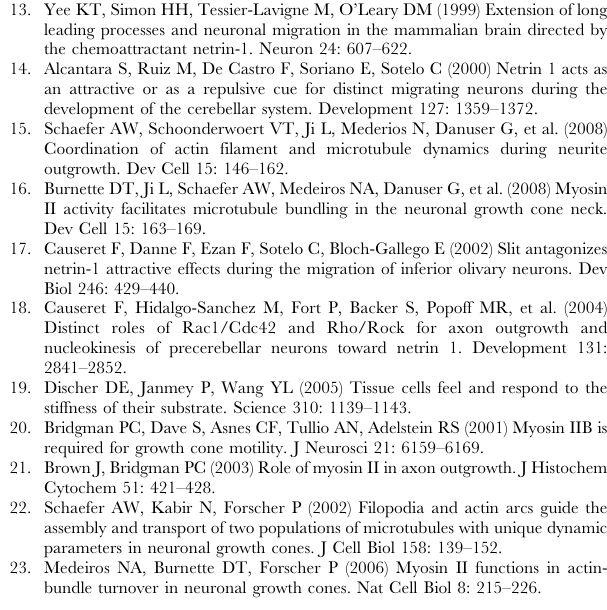
Figure S3 Comparison of neurites branching in wt and TTL 2 / 2 neurons growing in a collagen matrix. The aspect of GFP- electroporated growing neurites from wt (A, B) and TTL 2 / 2 (C, D) E12 explants toward Netrin-1 were observed after immuno- labeling with anti-GFP antibody. In wt, neurons extend straight neurites toward Netrin-1 without branching, neither proximally to the cell body nor distally along the neuritic extension (arrows in A, B) whereas in TTL 2 / 2 , branches are observed distally along the neurite, or close to the cell body where the leading process initiates (white arrows in C, D). Scale bar in A: 125 m m